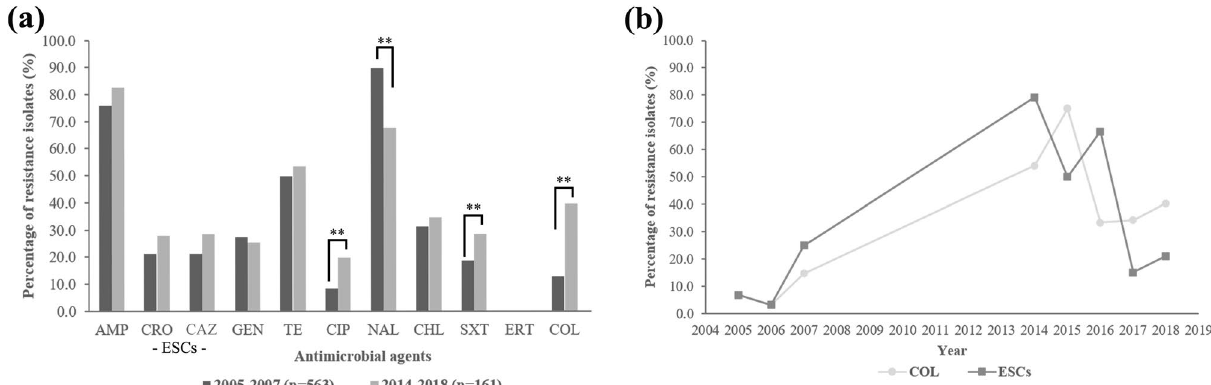
Figure 1. The AMR among 724 nontyphoidal Salmonella isolated from humans in Thailand during 2005–2007 and 2014–2018. ( a ) Comparison of AMR frequency in nontyphoidal Salmonella isolates between 2005–2007 and 2014–2018. ( b ) Frequency of ESC resistance and colistin resistance over time for nontyphoidal Salmonella isolated from patients from 2005–2016. AMP ampicillin, CRO ceftriaxone, CAZ ceftazidime, GEN gentamicin, TE tetracycline, CIP ciprofloxacin, NAL nalidixic acid, CHL chloramphenicol, SXT trimethoprim- sulfamethoxazole, ERT ertapenem, COL colistin, ESCs extended-spectrum